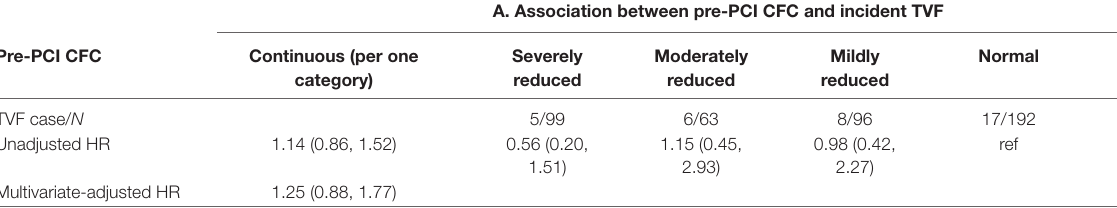
TABLE 6 | Association between pre- and post-PCI CFC and incident target vessel